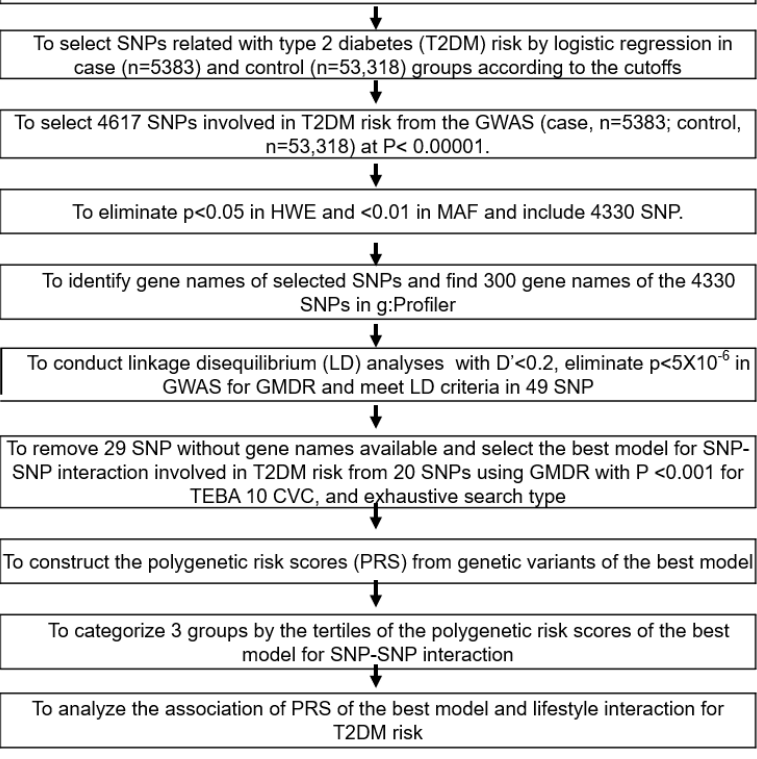
Figure 1. Flow chart for the generation of polygenic risk scores (PRS) to increase the type 2 diabetes risk and interactions between PRS and lifestyles. Type 2 diabetes was defined as ≥ 126 mmol/L of fasting plasma glucose level, ≥ 6.5% HbA1c, or currently taking anti-diabetic medication. T2DM (case; n = 5383) and the control (n = 53,318).